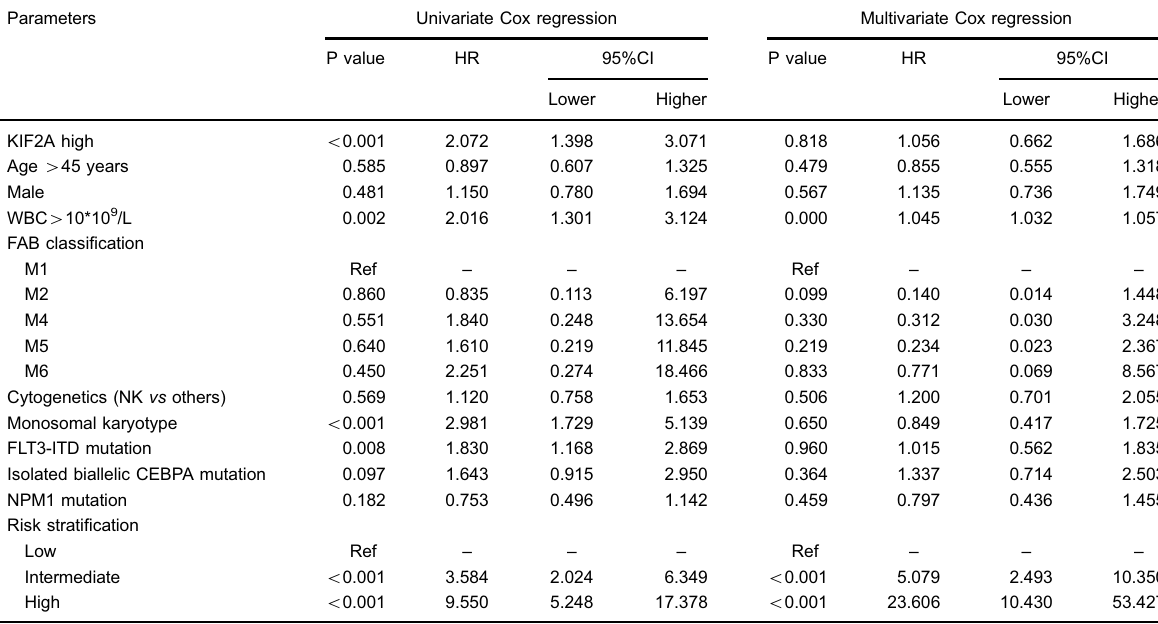
Table 3. Factors affecting event-free survival by Cox proportional hazards regression model analyses.